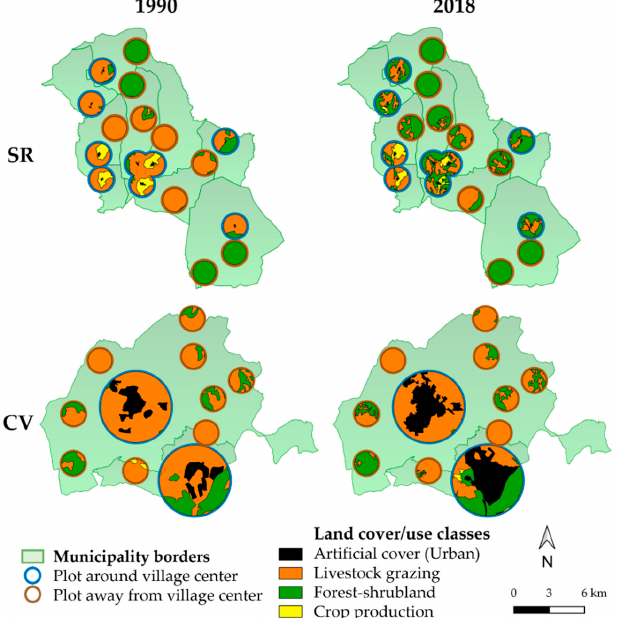
Figure 2. Mapping design and analysis based on two sets of plots placed on a portion of the territory. The map shows the land cover/use classes reclassified from CORINE Land Cover datasets of 1990 and 2018 for both study areas (CV and SR).